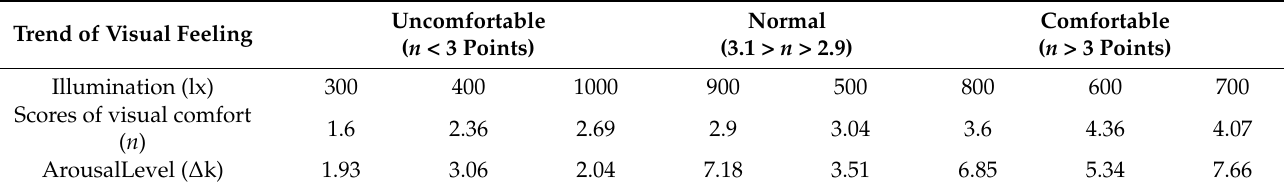
Table 10. Ranking of scores of the visual comfort questionnaire.